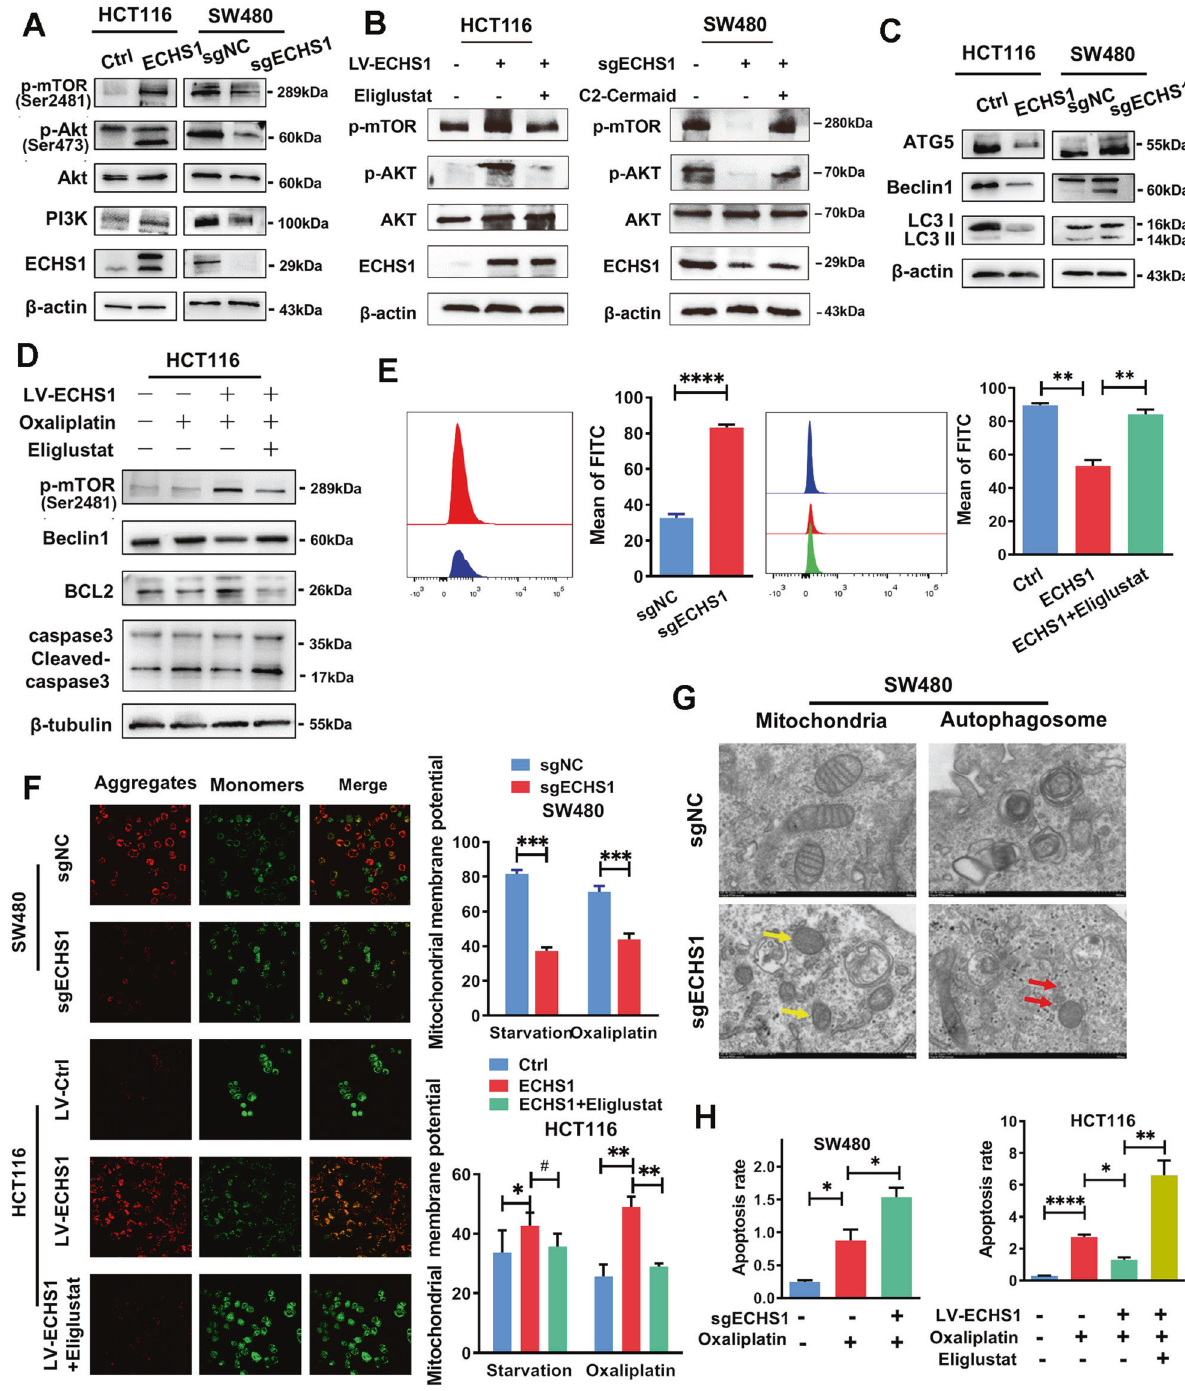
Fig. 4 ECHS1 resists autophagy and apoptosis of CRC cells through the PI3K-Akt-mTOR pathway mediated by ceramide. A Western blot analysis of the expression of PI3K/Akt/mTOR pathway members (PI3K, Akt, phosphorylated AKT at Ser473, and phosphorylated mTOR) in ECHS1-overexpressing or ECHS1-knockout CRC cells. B Western blot analysis of the expression of PI3K/Akt/mTOR pathway members in ECHS1- overexpressing cells with the application of the inhibitor of UGCG eliglustat (left panel) or in ECHS1-knockout cells with the addition of C2 ceramide (right panel). C Western blot analysis of the expression of autophagy-related proteins (ATG5, Beclin1, and LC3II/LC3I). D Western blot analysis of phosphorylated mTOR, Beclin1, BCL2, and caspase3 in CRC cells with or without ECHS1 overexpression and Eliglustat (100 nmol). E Flow cytometry analysis of intracellular ROS content. Bars in the right panel represent the average fl uorescence intensity. F IF assay analysis of JC-10 aggregates (red) and monomers (green) in the mitochondrial matrix with or without starvation (2 h) and Eliglustat (100 nmol). Bars of the right panel represent the ratio of the average fl uorescence intensity of monomers (green) and aggregates (red). G Electron microscopy results show mitochondrial morphology (yellow arrows) and autophagosomes (red arrows) in ECHS1-knockout SW480 cells. H Histogram of fl ow cytometry assay showing the ratio of the average fl uorescence intensity of apoptotic cells with or without Oxaliplatin (20 µg/µl) and Eliglustat (100 nmol).